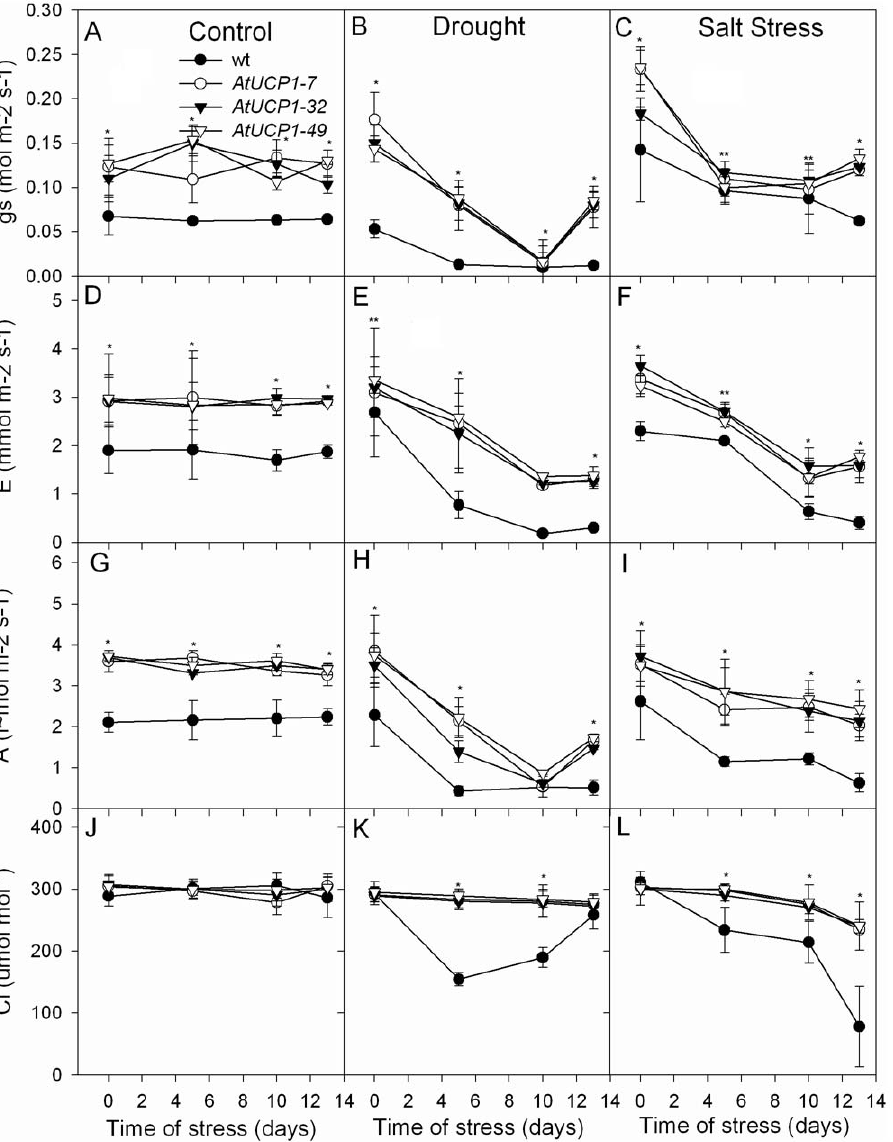
Figure 4. Effects of drought and salt stresses on stomatal conductance, transpiration rate, net photosynthesis and internal leaf CO 2 concentration of wild-type (WT) and AtUCP1 transgenic plants. Thirty-day-old plants were exposed for 10 days to 200 mM mannitol or 175 mM NaCl and then recovered with pure water for 3 days. A–C: stomatal conductance (gs); D–F: transpiration rate (E); G–I net photosynthesis (A); J–L: internal leaf CO 2 concentration (Ci). A, D, G and J: control treatment. B, E, H and K: 200 mM mannitol. C, F, I and L: 175 mM NaCl. * and ** indicate significant differences relative to the control at P , 0.0001 and P , 0.001, respectively.